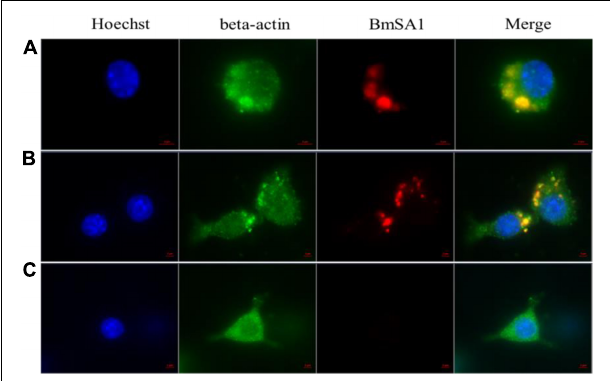
FIGURE 5 | Immunolocalization of B. microti internalized in macrophages. (A) Incubation of B. microti- infected RBCs with macrophages for 1 h. (B) Incubation of B. microti -infected RBCs with macrophages for 2 h. (C) Negative control: incubation of normal RBCs with macrophages. Scale bar = 2 µ